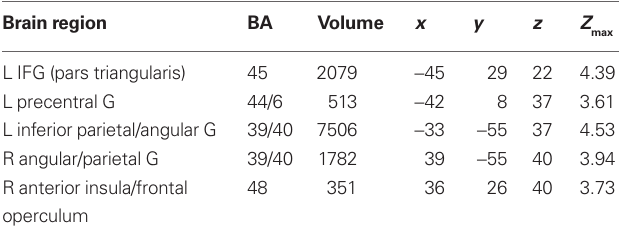
Table 2 | Whole-brain ANOVA.